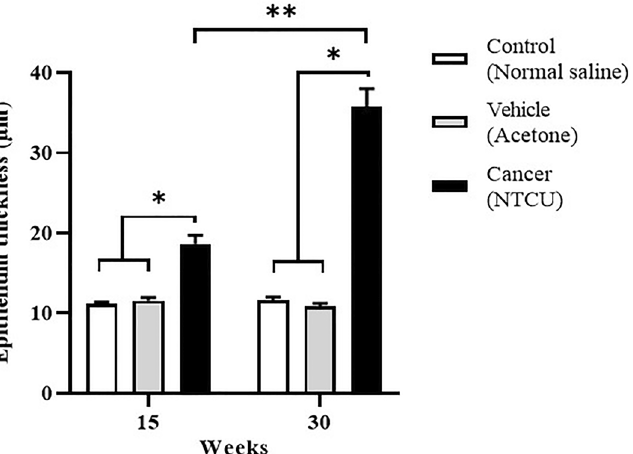
Figure 4. Epithelium thickness after 15 (pre-malignant stage) and 30 weeks (malignant stage) of treatment with normal saline, acetone, and NTCU. *Significant difference ( P < 0.05) between groups in the same stage. **Significant difference between cancer groups from two different